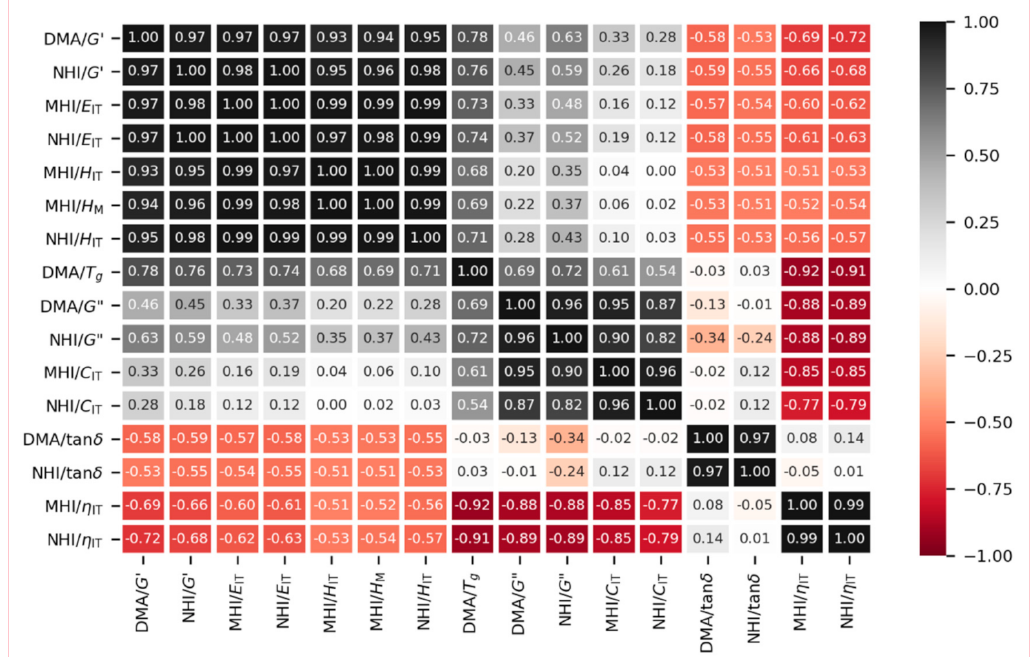
Figure 11. Correlation matrix table showing Pearson (cid:48) s coe ffi cients r for all pairs of experimentally determined properties in macro-, micro- and nanoscale. The table is presented as a heatmap (darker color means stronger correlation). The properties in the table are: storage modulus, loss modulus, damping factor and glass transition temperature from dynamic mechanical analysis (DMA / G (cid:48) , DMA / G ”, DMA / tan( δ ) and DMA / T g ), analogous properties from dynamic nanoindentation experiments (NHI / G (cid:48) , NHI / G ”andNHI / tan( δ )), indentationhardness, modulus,